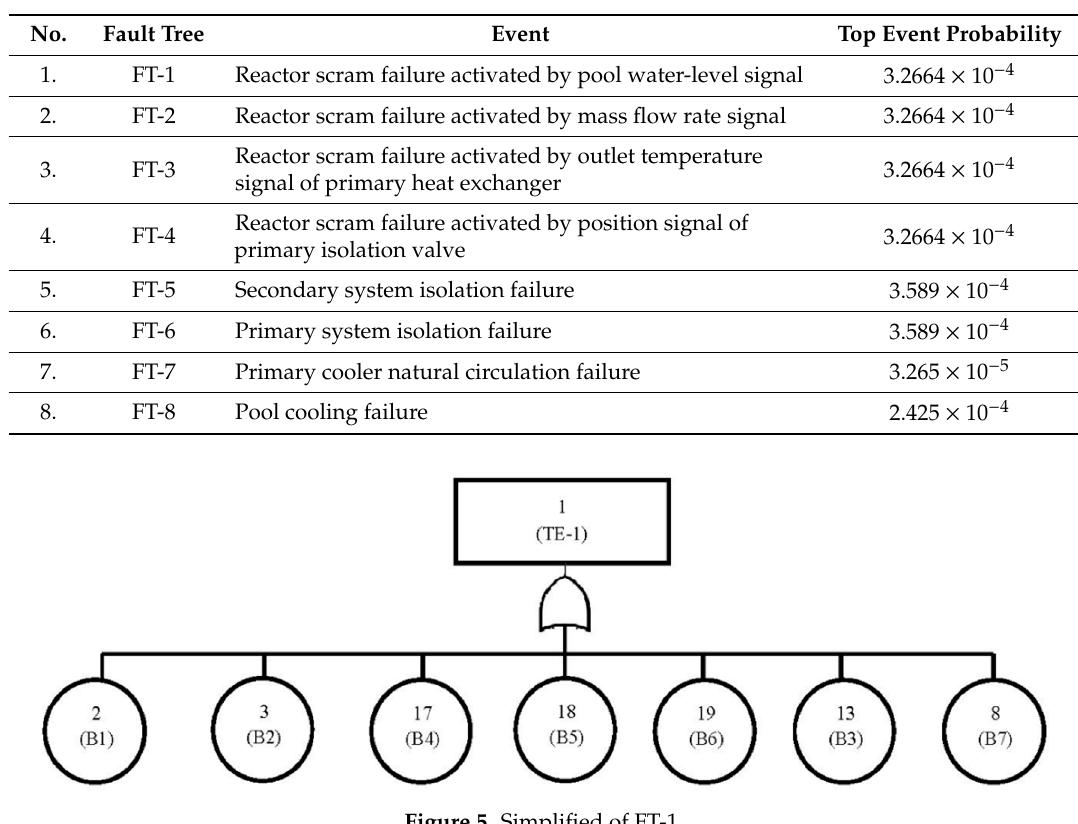
Table 6. The probability of the top event.